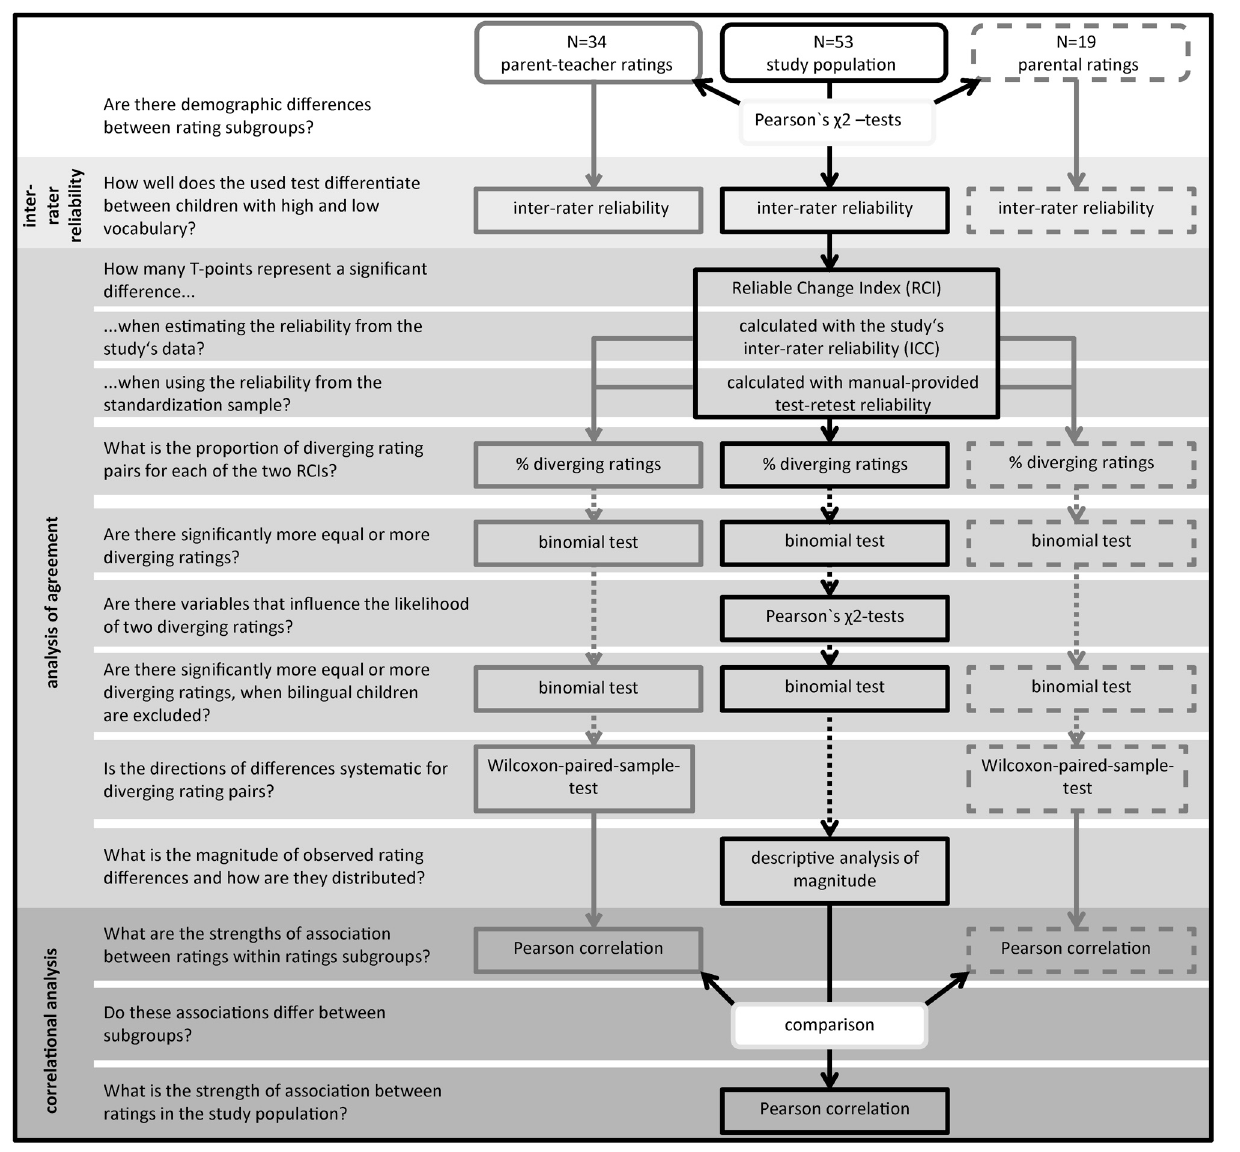
rating subgroup ( n = 19) are shown. The column in the middle lists tests conducted for the whole study population, as well as between group comparisons. Dotted arrows mark analyses conducted for the differing ratings identified using the manual’s test-retest reliability (no reliably diverging ratings were identified if using the ICC for calculating the critical difference between